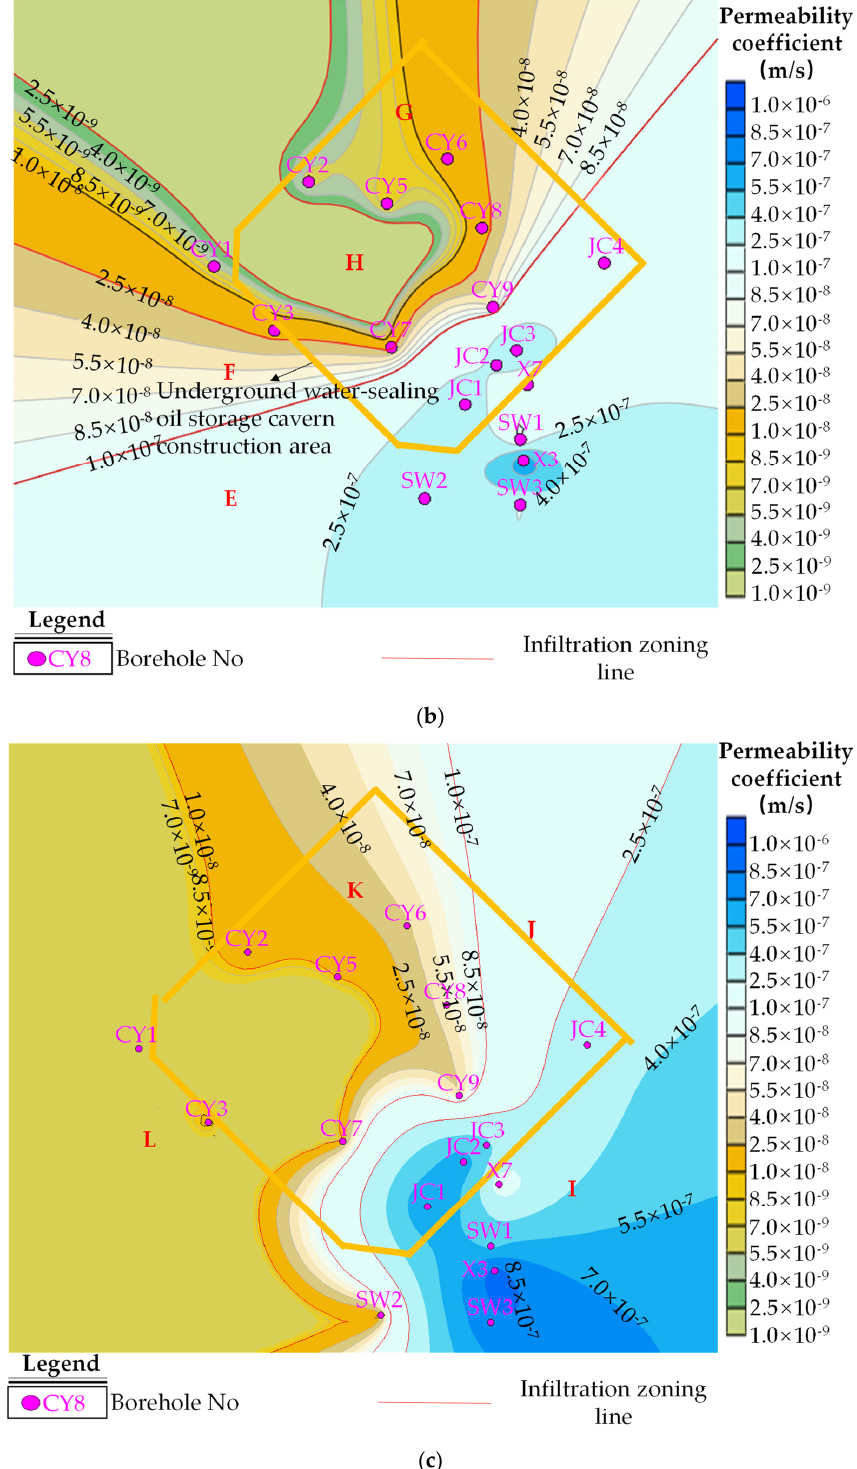
Figure 7. Permeability coefficient distribution at different elevations in the model: ( a ) between − 38 and − 20 m; ( b ) between − 62 and − 38 m; ( c ) between − 92 and − 62 m.